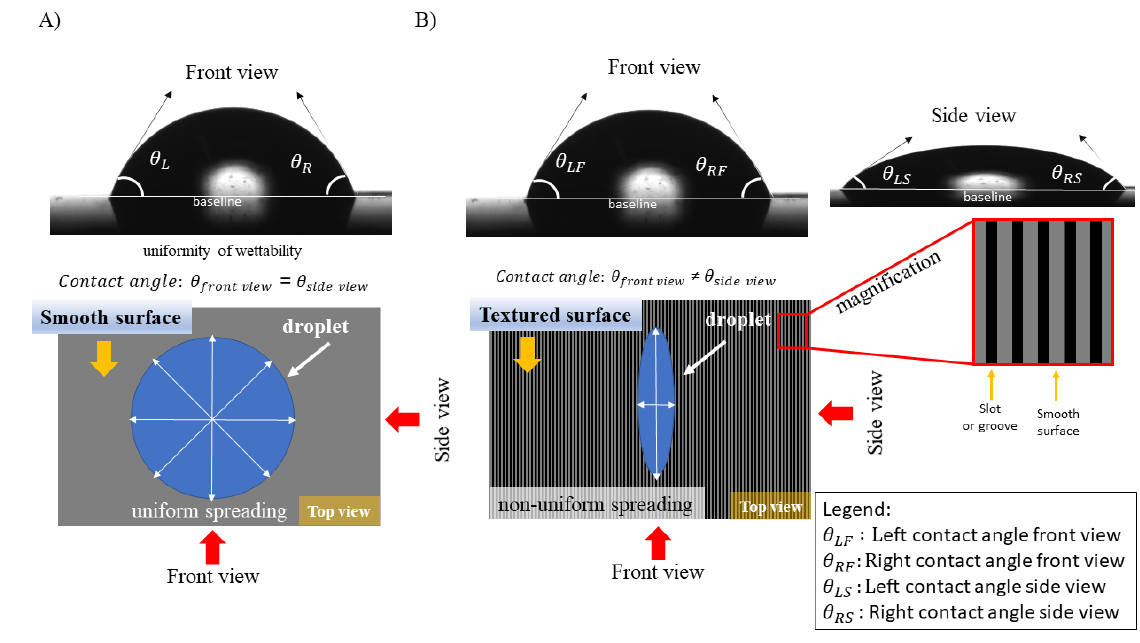
Figure 3: Analysis of wettability for smooth surfaces and with directional micro textures. A) Uniform wetting behaviour, the front and side views of wettability have similar contact angles. B) Directional micro textures with a difference in the contact angle as a function of direction. In this case, the contact angles in the front view will be different from the side